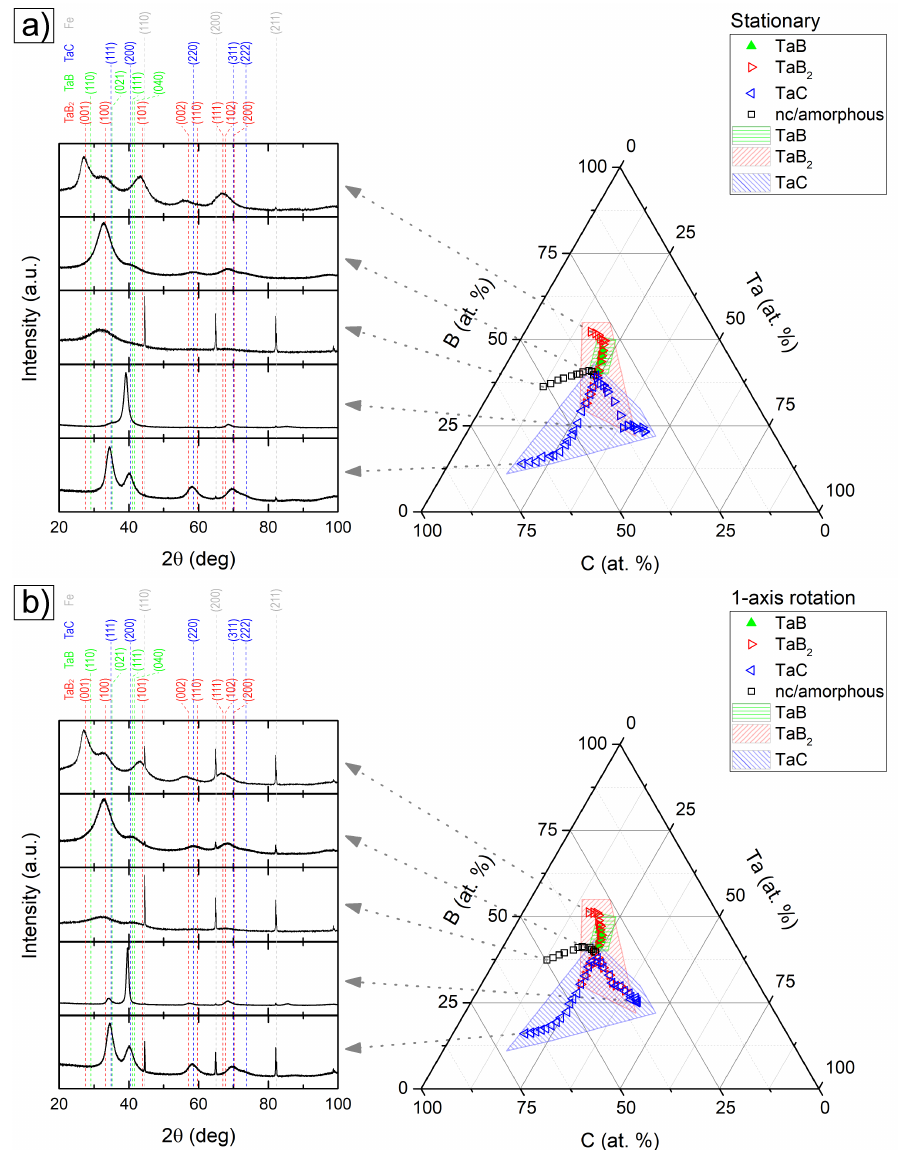
Figure 8. Identified crystalline phases. Typical diffraction patterns with reference peak positions are provided on the left: ( a ) stationary samples; ( b ) rotating